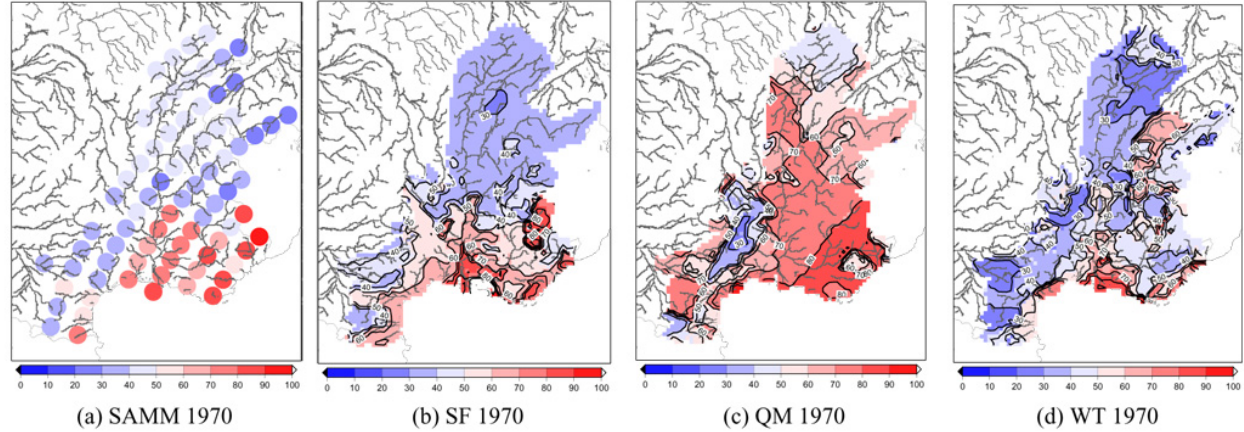
Fig. 5. PXCDD in the region of interest obtained from SAMM, SAFRAN/F and the downscaling methods for the period 1970–1999.